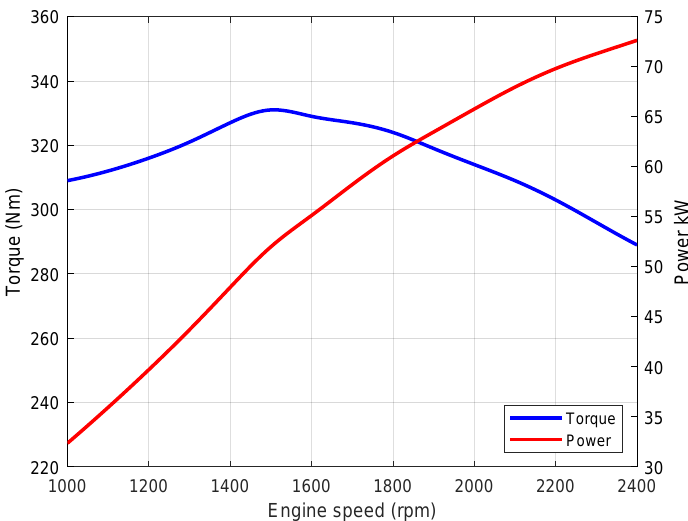
Figure 2. Torque and power characteristics for the diesel engine of a conventional